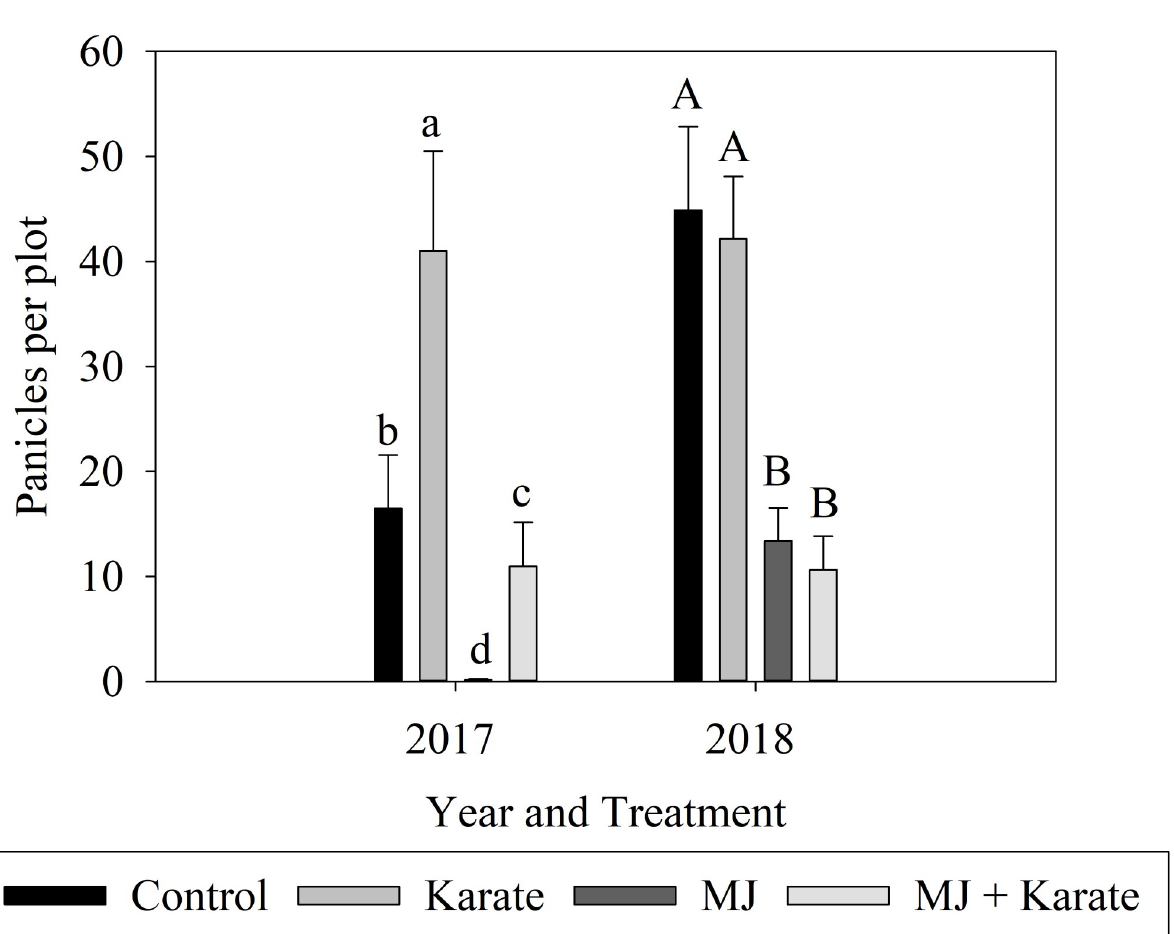
Fig 5. Effects of factorial combinations of methyl jasmonate seed treatment (MJ) and application of insecticide (Karate) on panicle densities (numbers of panicles per plot ± S.E.). Data were pooled over three sampling dates from 80 to 87 days after seeding in 2017 and two sampling dates from 101 to 108 days after seeding in 2018. Treatments included MJ–treated (MJ), insecticide-treated (Karate), MJ- and insecticide-treated (Both), and non-treated plots (Control). Bars accompanied by different letters represent means that differed significantly by Tukey’s HSD test at α <